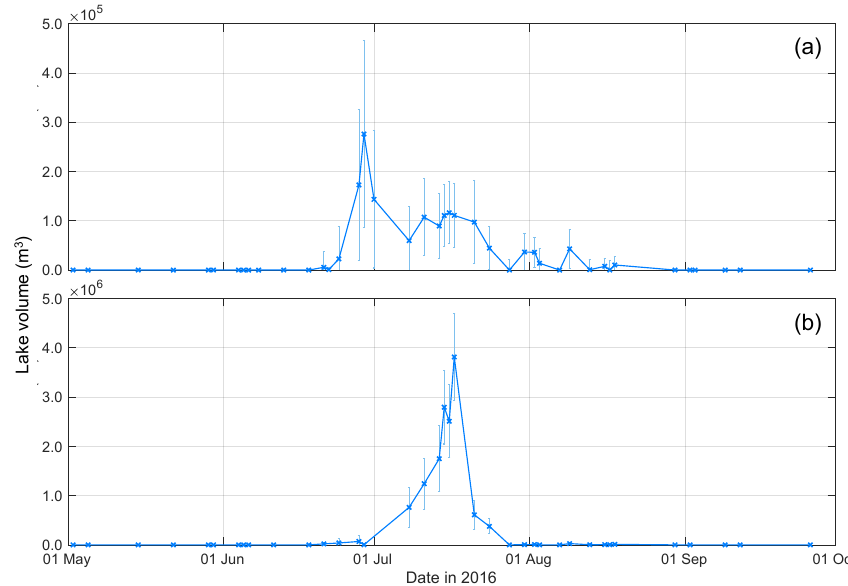
Figure 5. Sample time series of lake volume to show seasonal changes for (a) a non-rapidly draining lake (Fig. 1, red circle) and (b) a rapidly draining lake (Fig. 1, green box). Lines connect points without any data smoothing. Error bars were calculated by multiplying the lake depth RMSE of 0.555m (Sect. 3.1) by the pixel size and the number of pixels in the lake on each image.